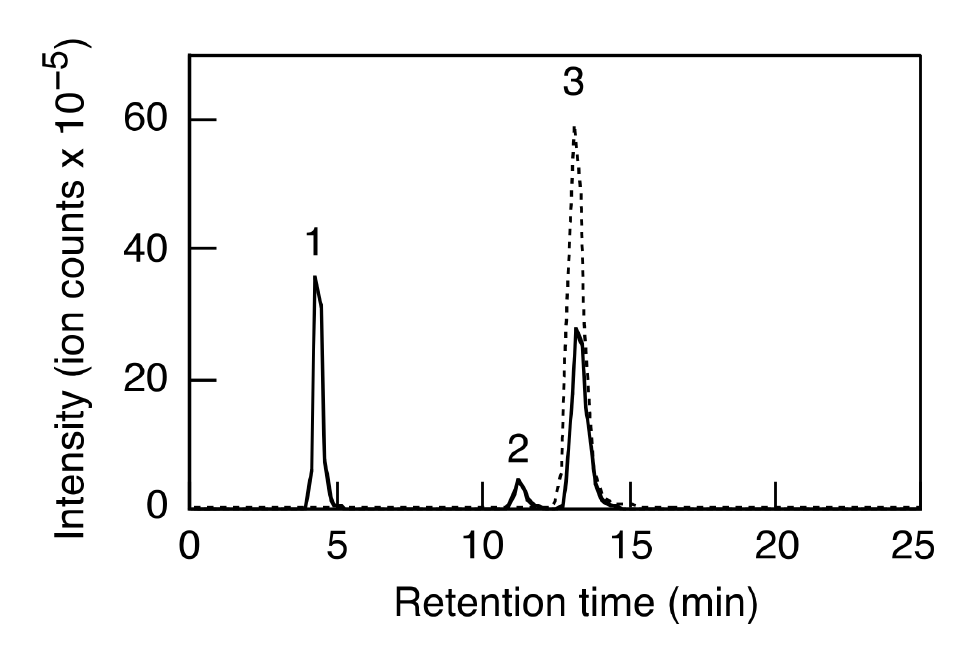
Figure 2. LC/ESI mass chromatogram of the sample solution (methanolic extract) prepared from the salivary gland of Neptunea polycostata . This figure corresponds to Figure 4a in the paper of Kawashima et al. [46]. Solid line: sample solution. Broken line: sample solution spiked with tetramine. Monitored at 30 V for m/z 118 (glycine betaine, 1), m/z 76 (trimethylamine oxide), m/z 104 (choline, 2), and